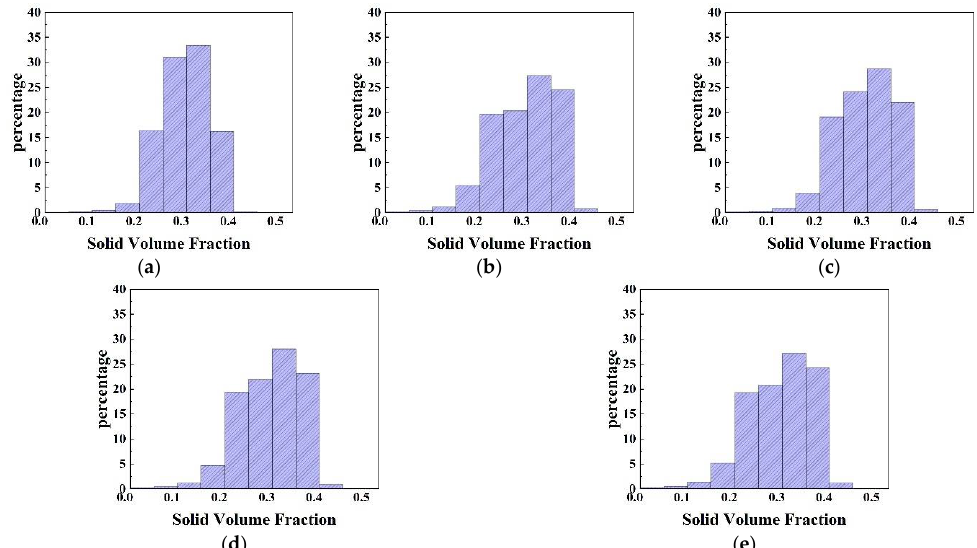
Figure 21. Histogram of solid distribution for DRFTBI with different connection strap widths. ( a ) D/5; ( b ) D/6; ( c ) D/7; ( d ) D/8; and ( e ) D/9. (Rotational speed: 120 rpm; solid loading: 30%; connection strap length: 1.2 Hs.)